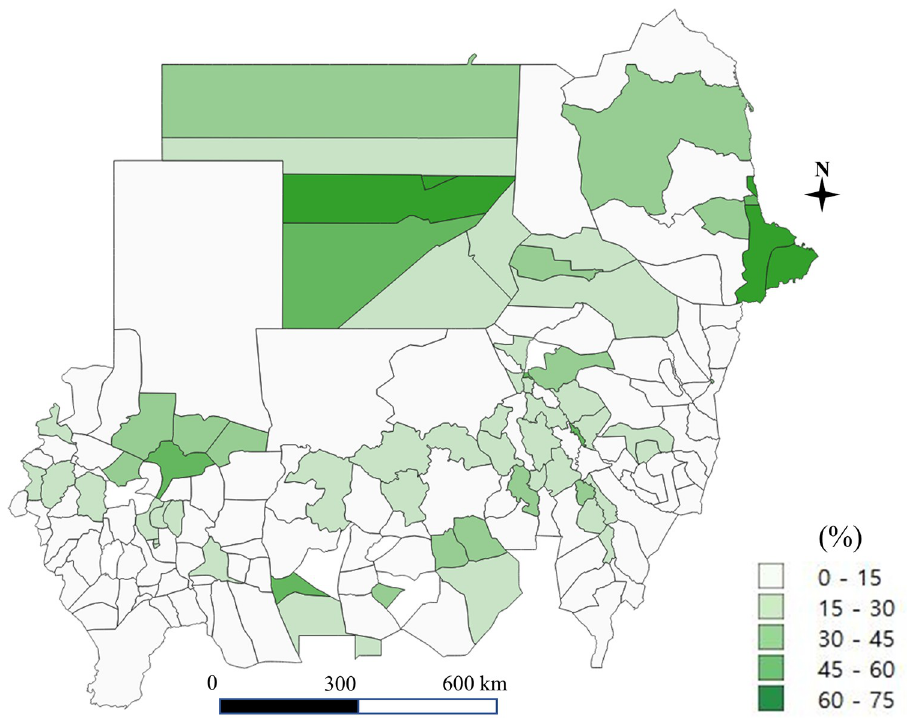
Fig 1. Improved latrine at the household level (the authors generated the map).